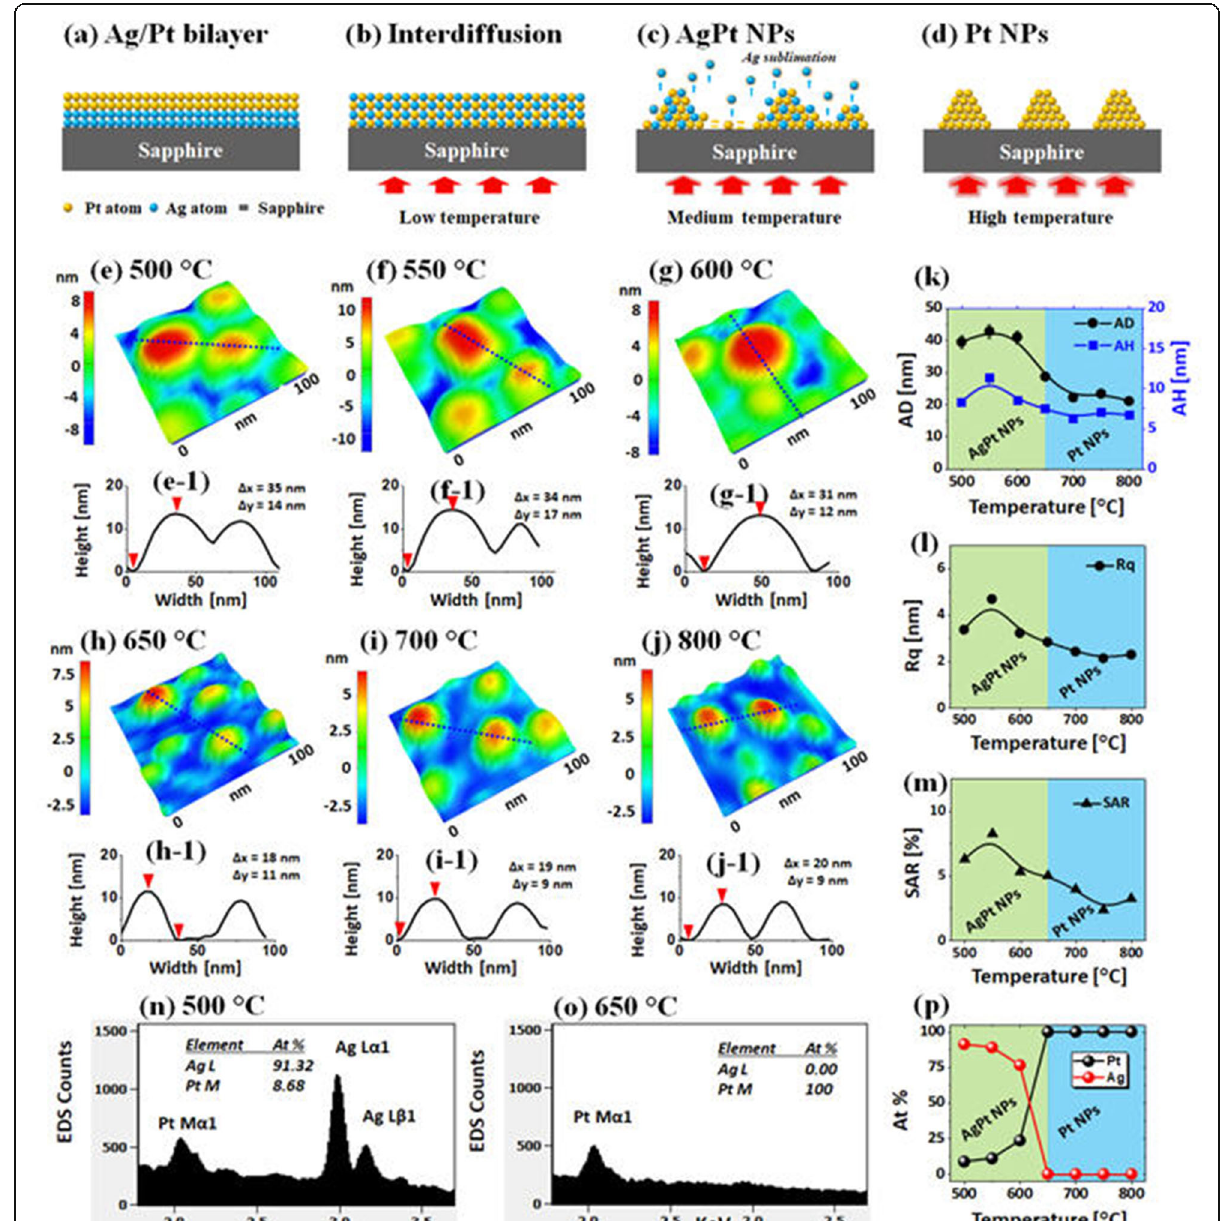
Fig. 1 Fabrication of AgPt and Pt NPs with the Ag 7nm /Pt 1.5nm bilayers by annealing between 500 and 800 °C for 120 s. ( a ) – ( d ) Schematic illustration of the formation of AgPt and Pt NPs from the Ag/Pt bilayers. ( e ) – ( j ) Atomic force microscope (AFM) side-views. ( e - 1 ) – ( j - 1 ) Cross- sectional line profiles across the typical NPs in ( e ) – ( j ). ( k ) Summary plots of average diameter (AD), average height (AH). ( l ) – ( m ) RMS roughness (Rq) and surface area ratio (SAR). ( n )-( o ) Energy dispersive x-ray spectroscopy (EDS) spectra of the samples annealed at 500 and 650 °C. ( p ) Summary plots of atomic (at) % of Pt and